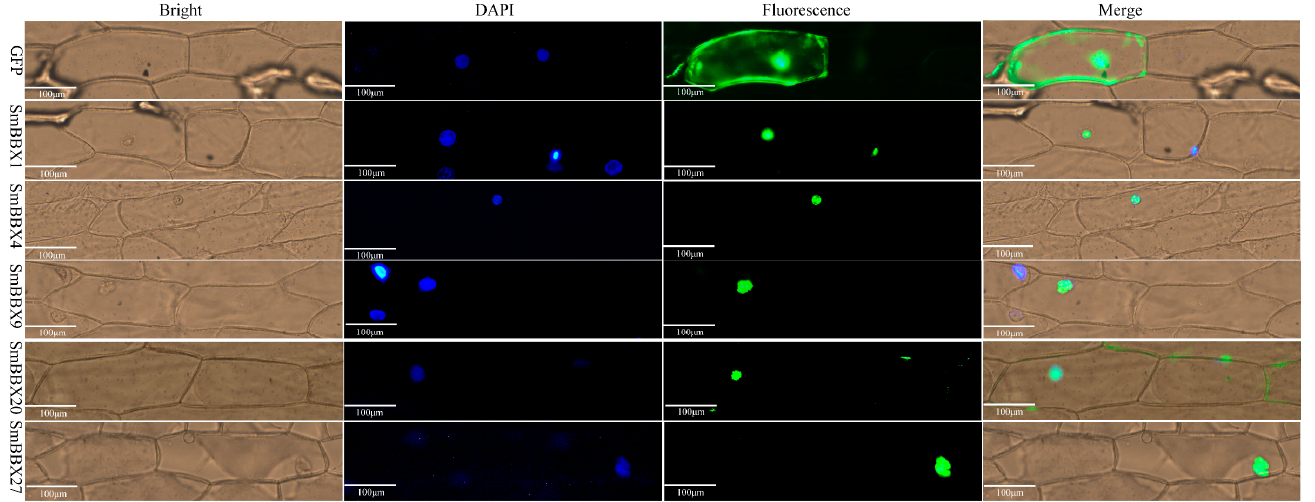
Figure 7. Subcellular localization analysis. All candidate genes were independently cloned into vector pEarleyGate103. Subcellular localization of SmBBX1-GFP, SmBBX4-GFP, SmBBX9-GFP, SmBBX20-GFP, and SmBBX27-GFP in the nucleus was confirmed in onions via laser confocal microscopy. Scale bars = 100 μ m.